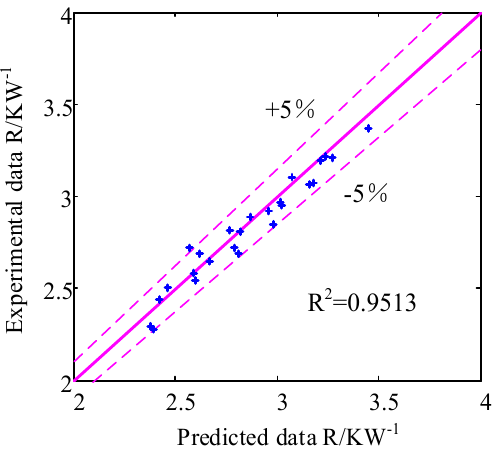
Figure 9. Comparison of the predicted data (Equation (46)) with the experimental data. Table 3. Predictive and experimental values of the total thermal resistance of the thermosyphon. Inclination Angle ( ◦